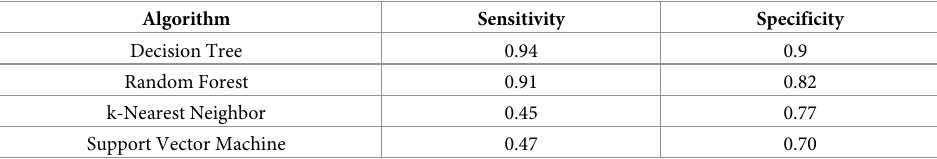
Table 3. Predictive performance